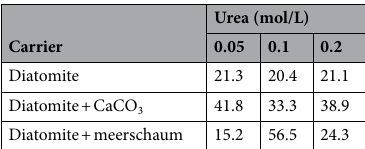
Table 3. Particle size of nano-TiO 2 (nm). TiOSO 4 : 0.01